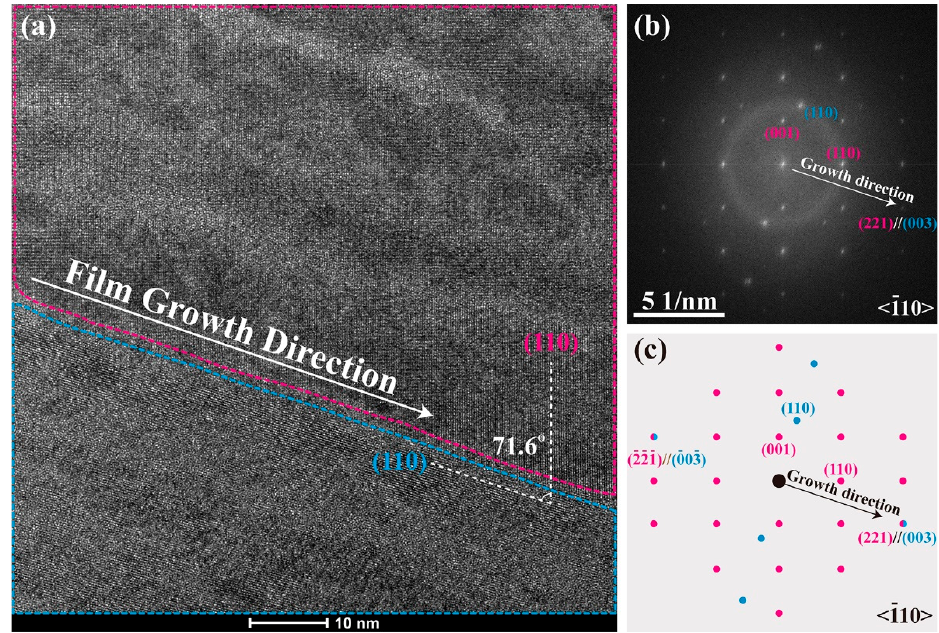
Figure 5. ( a ) A high-resolution TEM image of the as-grown BZT film with a < − 1 1 0> zone axis near the bottom electrode, ( b , c ) are an FFT electron diffraction pattern from ( a ) and a schematic drawing for the diffraction pattern (blue dots: {00 l } R phase, red dots: (221) T ).